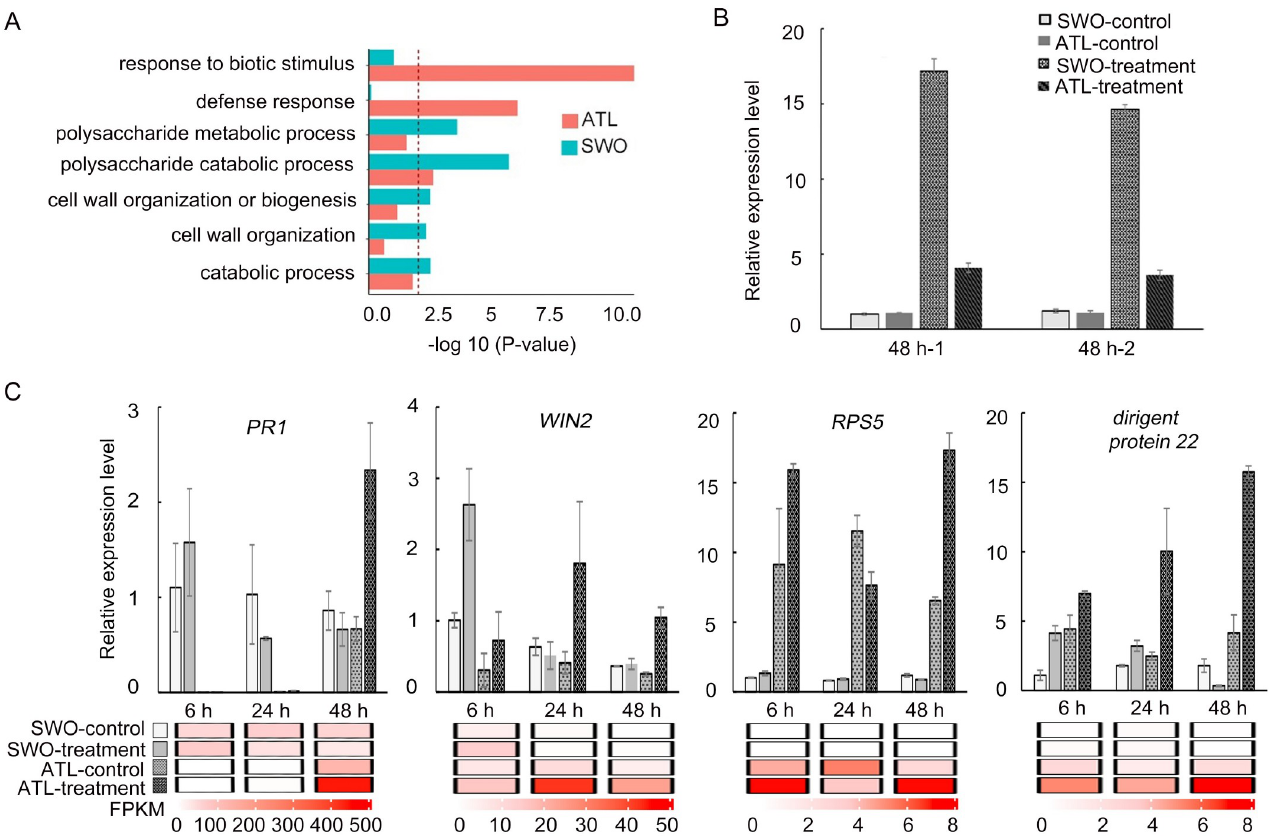
Fig 3. Differentially expressed genes in Atalantia and sweet orange after Xcc (10 8 CFU/ml) inoculation. (A) GO enrichment analysis of the up-regulated genes in Atalantia (ATL) and sweet orange (SWO) at 48 h after inoculation. (B) qRT-PCR validation of LOB1 expression in Atalantia and sweet orange at 48 h after inoculation with Xcc and sterile water. (C) Expression levels of four DEGs: pathogenesis-related gene 1 ( PR1 ), Resistance to Pseudomonas syringae 5 ( RPS5 ), HopW1-1-Interacting 2 ( WIN2 ), and dirigent-like protein 22 genes, and their corresponding expression patterns in RNA-Seq data in Atalantia and sweet orange. The treatment group was inoculated with Xcc and the control group was inoculated with sterile water at 6 h, 24 h, and 48 h. All the gene expressions were normalized according to the gene expression of the sweet orange control group at 6 h post inoculation. The relative expression level was calculated by 2 - 44 Ct method with EF1a as the reference gene. Error bars indicate standard deviation of three independent repetitions.